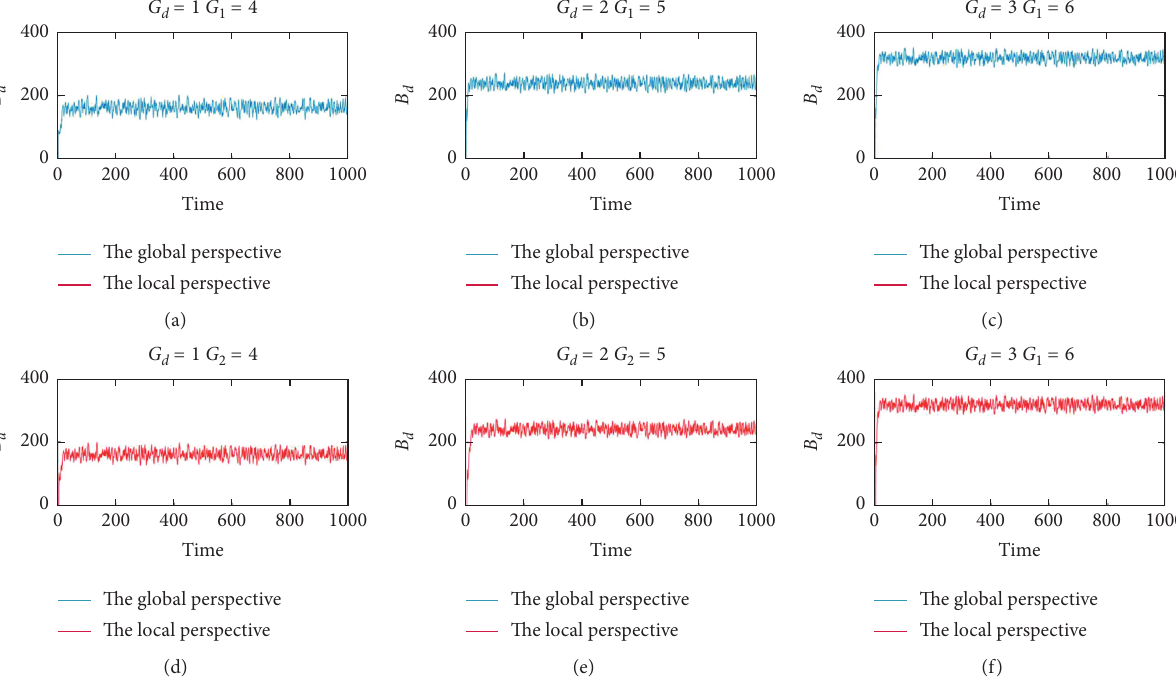
Figure 23: The initial inventory changes of the distribution center in a stable state under the scenario of random demand obeying uniform distribution from different perspectives.